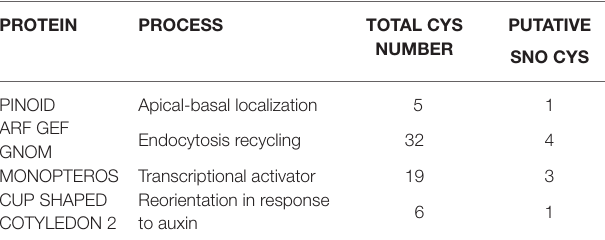
TABLE 1 | Analysis of putative S -nitrosation modifications in Cys residues from the main proteins implicated in the regulation of PIN-FORMED 1 (PIN1) by using the GPS-SNO 1.0